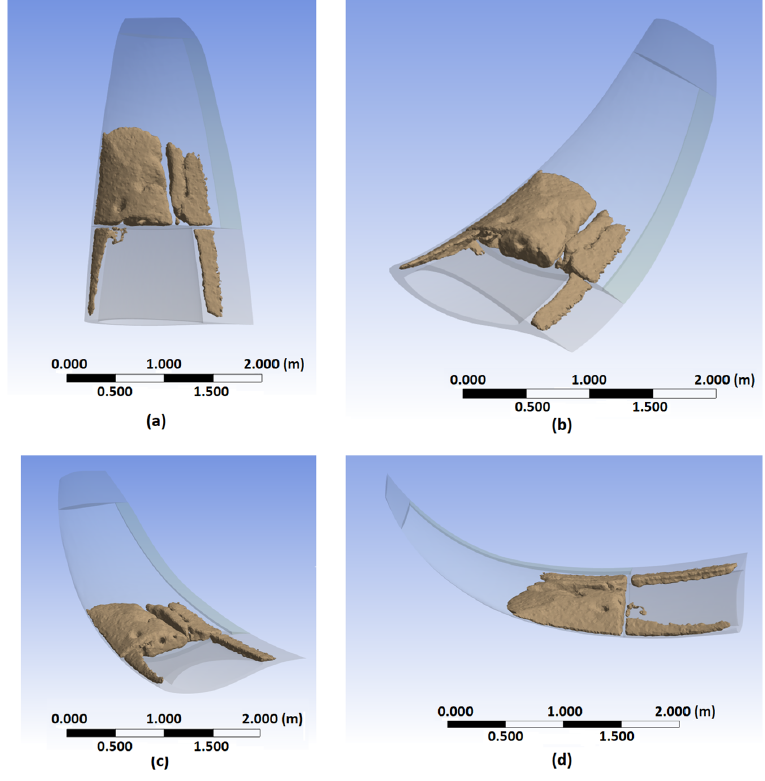
Figure 11. Interior material removal schematic via TO. ( a ) Top view, ( b ) isometric back view, ( c ) isometric front view, ( d ) front view.